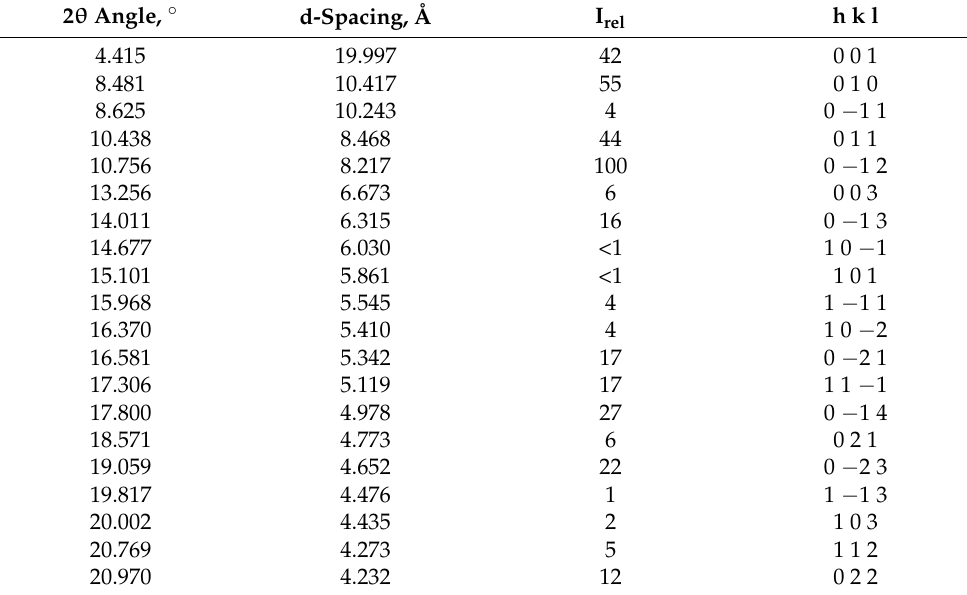
Table 5. List of observed 2 θ angles, d-spacings, and relative intensities, jointly with reflection indices, for Eltrombopag Form